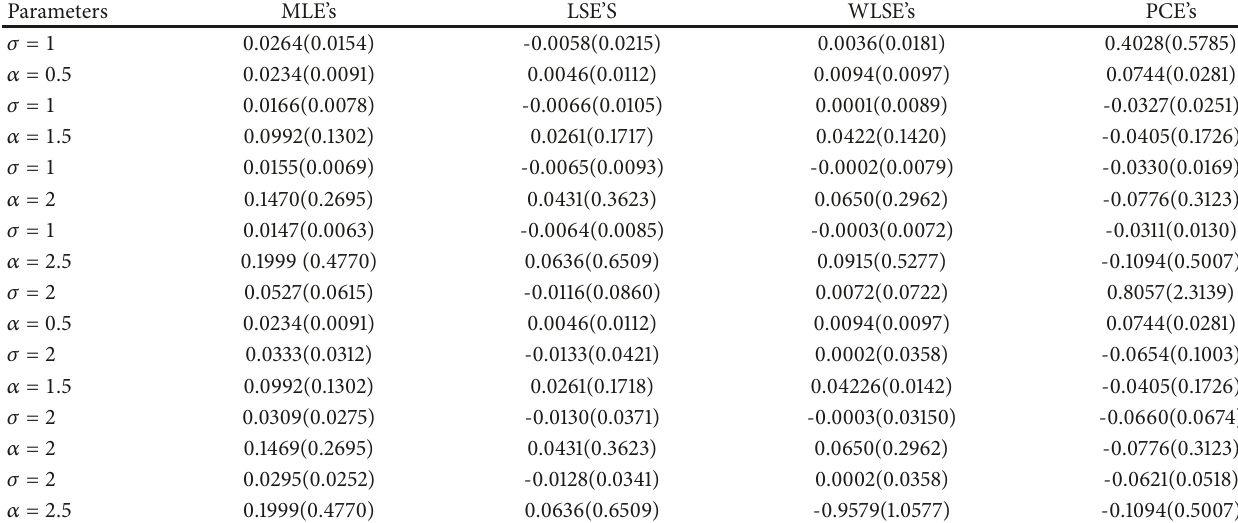
Table 3: Average bias values of estimates and their MSE (in brackets) when n=50.